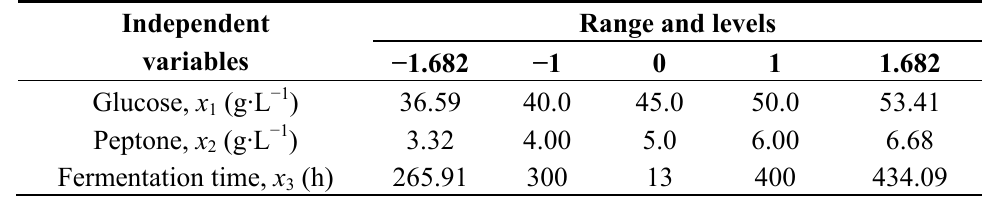
Table 1. Experimental range and levels of the independent variables of ganoderic acid Me (GA-Me)